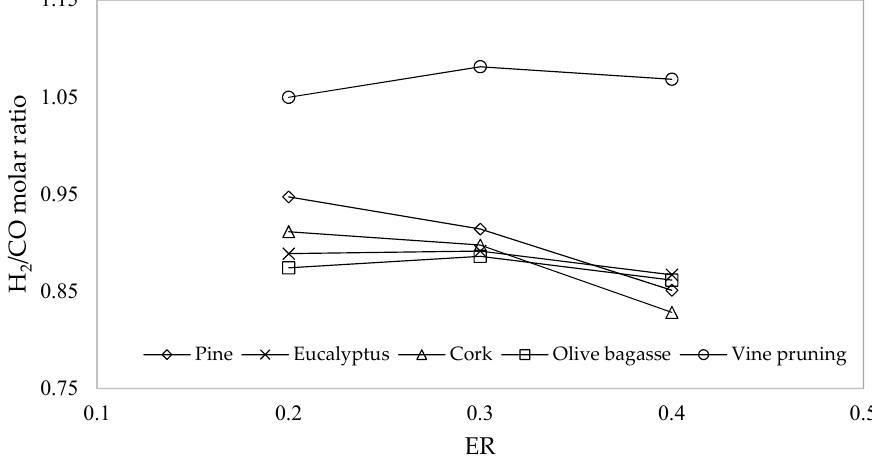
Figure 4. Produced gas H 2 / CO molar ratio as a function of equivalence ratio (ER) for various biomasses.